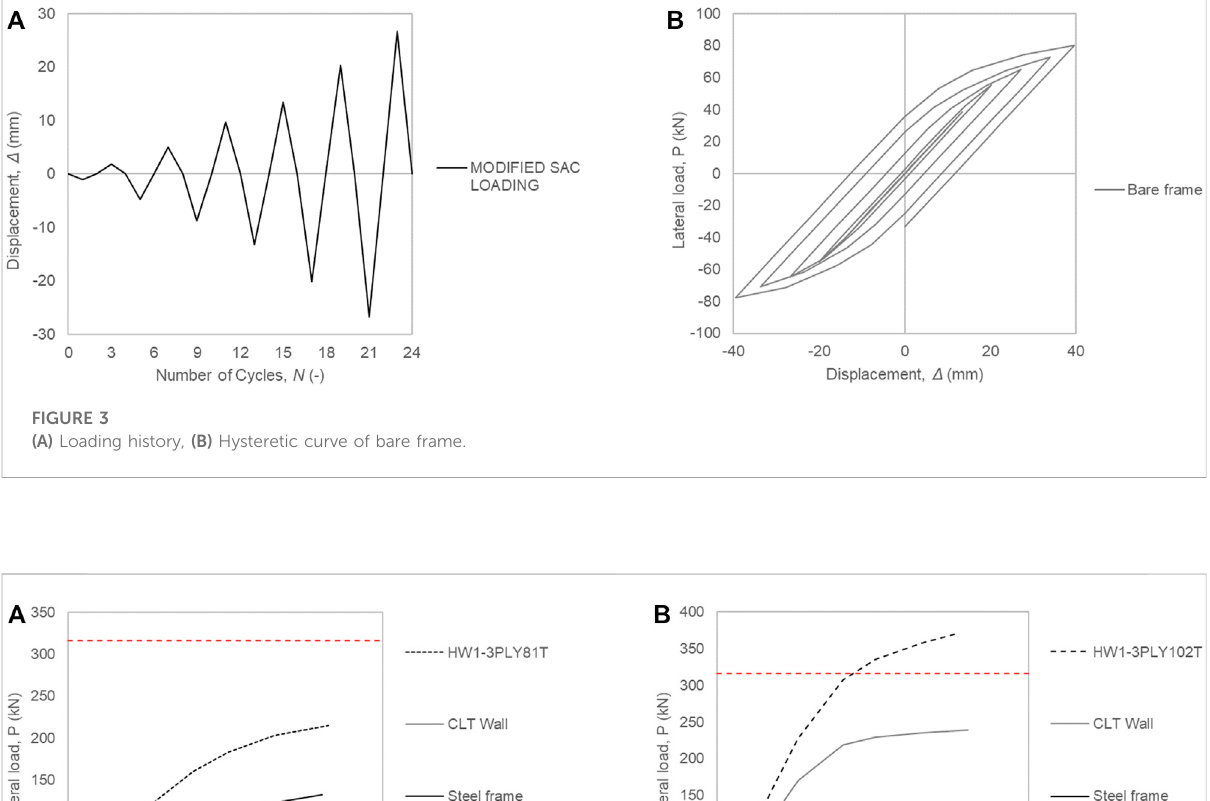
provision, using an acceleration and velocity coef fi cient of 0.4 and a force reduction factor R, of 5.5, (larger than the Eurocodes ’ requirement for q due to overstrength) (Vogiatzis,